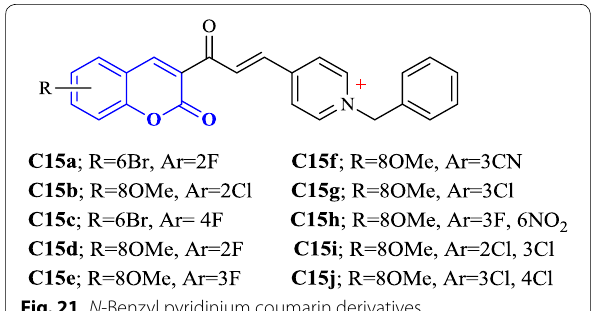
Fig. 21 N -Benzyl pyridinium coumarin